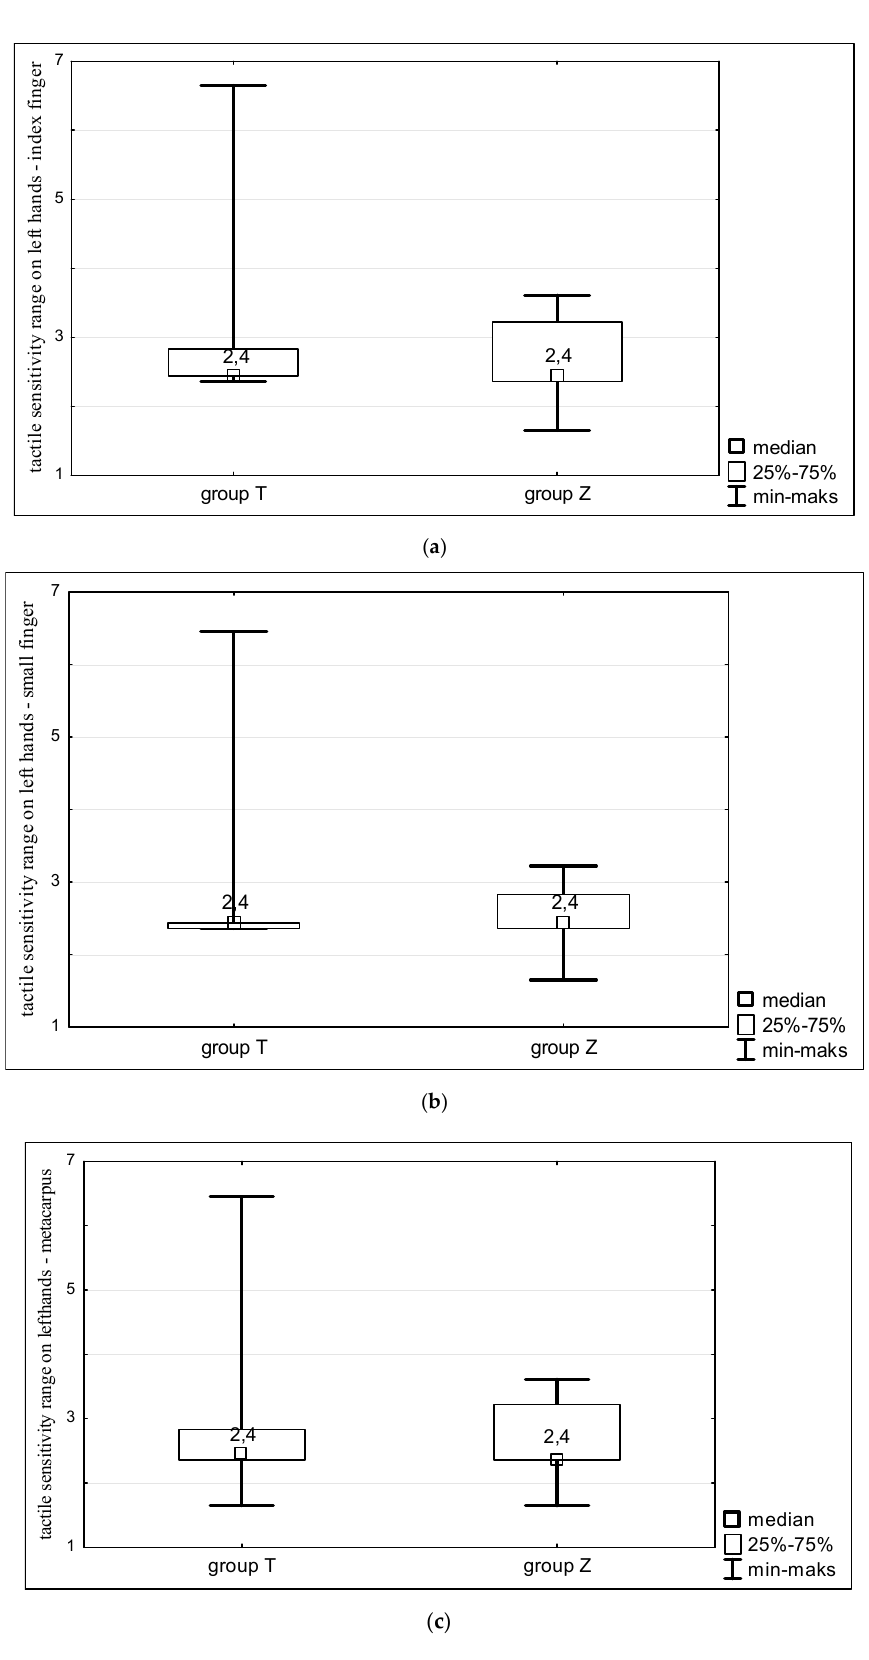
Figure 2. Tactile sensitivity of left hands of women with Turner syndrome (group T) and healthy women (group Z). Sensitivity measurements taken at: ( a ) the index finger; ( b ) small finger; and ( c ) metacarpus.